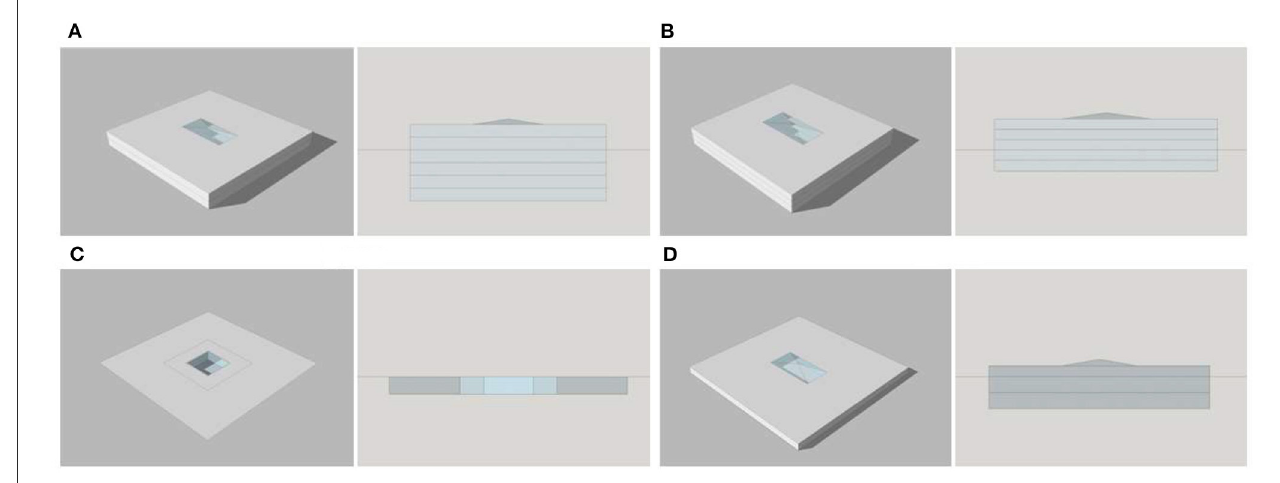
FIGURE2 Aerial view and profile view of four standard models. Image source: self-drawn by the author. (A) TUAI. (B) TCAI. (C) TCSI. (D) THAI.